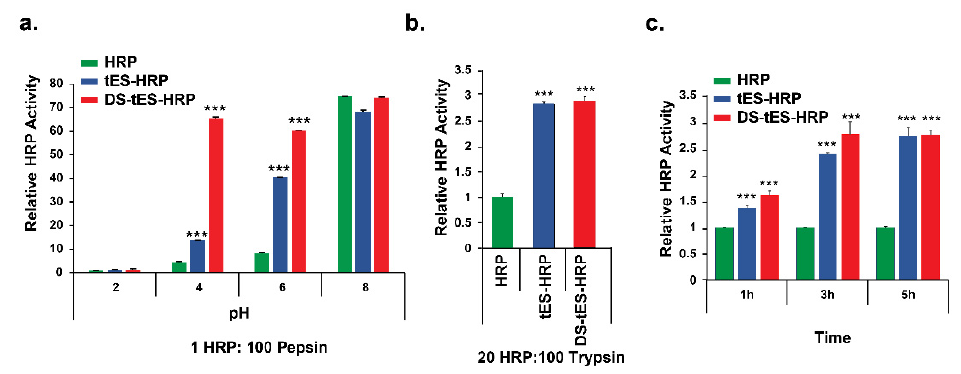
Figure 3. ( a ) Pepsin assay under different pH conditions. DS-tES protected the encapsulated HRP from the simulated gastric condition. ( b ) Trypsin assay, tES and DS-tES protect the HRP against trypsin enzyme. ( c ) Permeability assay in Caco2 monolayers shows that both tES and DS-tES can permeabilize through intestinal epithelium. (( a – c ): data are shown as mean ± SEM, n = 3. *** p < 0.001.).